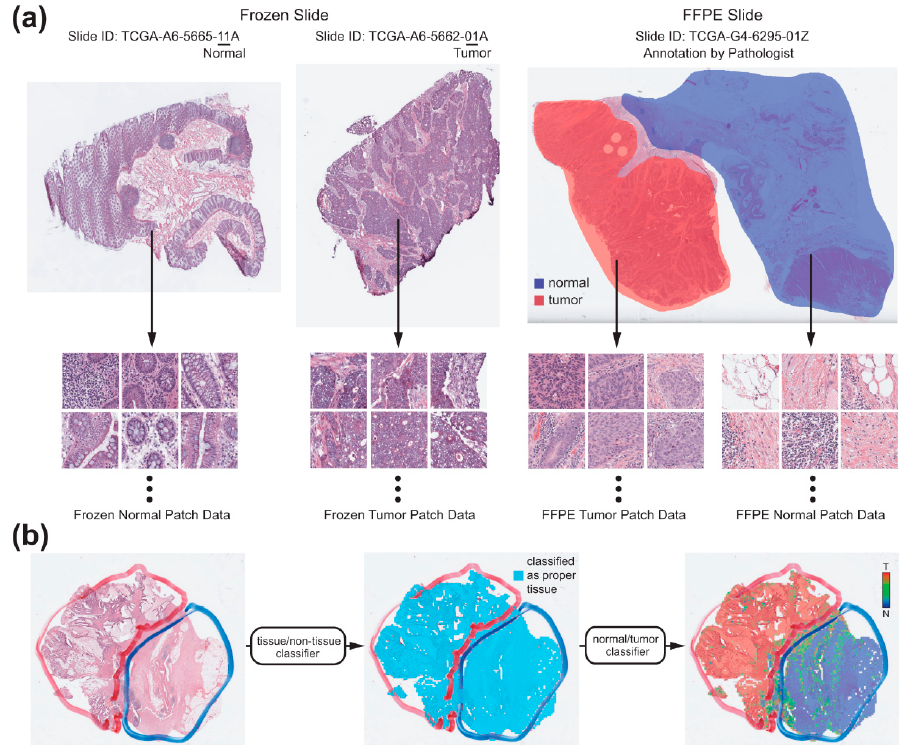
Figure 1. The workflow of the fully automated normal/tumor classifiers for whole slide images (WSIs). ( a ) Collection of the normal and tumor tissue image patches. For the frozen tissue WSIs, normal and tumor patches were collected depending on the IDs of the WSIs. For the formalin-fixed paraffin-embedded (FFPE) tissue WSIs, two pathologists annotated the normal and tumor regions. Normal and tumor patches were collected depending on the annotations. ( b ) Classification process for a representative WSI. At first, only proper tissue patches were selected by the tissue/non-tissue classifier. Then, the tumor probabilities of the proper tissues were obtained by the normal/tumor classifier. Finally, a heatmap was drawn to demarcate the normal/tumor distribution.